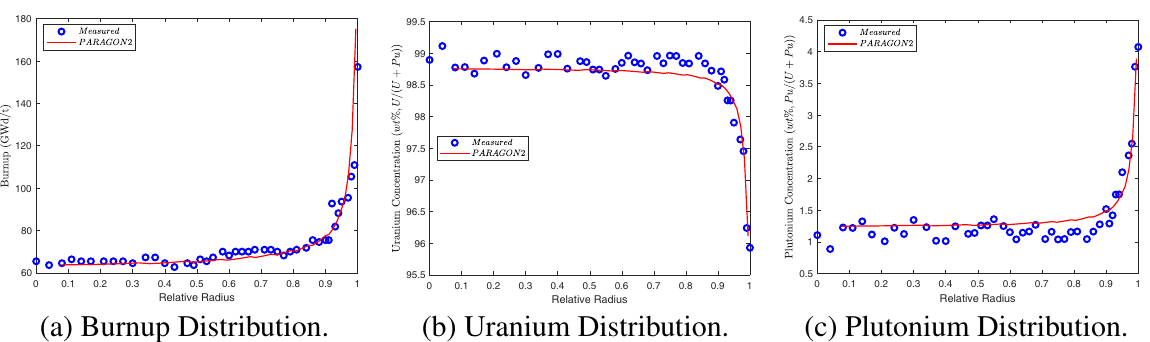
Figure 3: UO Radial Pellet Distribution of Burnup, Uranium and Plutonium 2